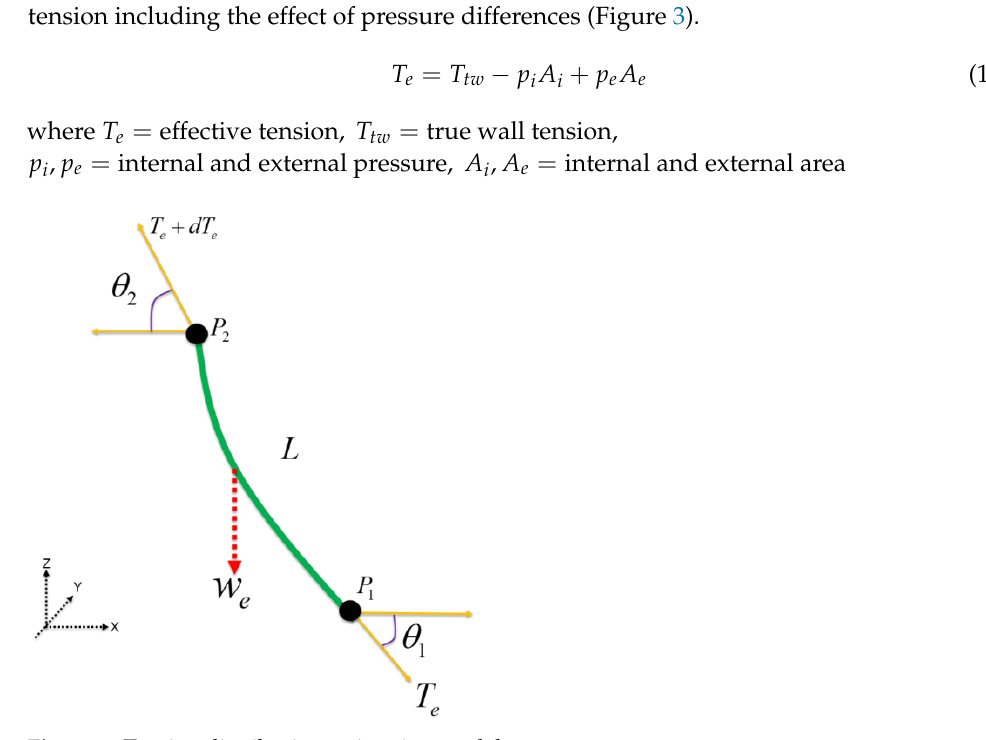
Figure 2. Configuration for Node Displacements and Discretized Bending Moment Tracing.